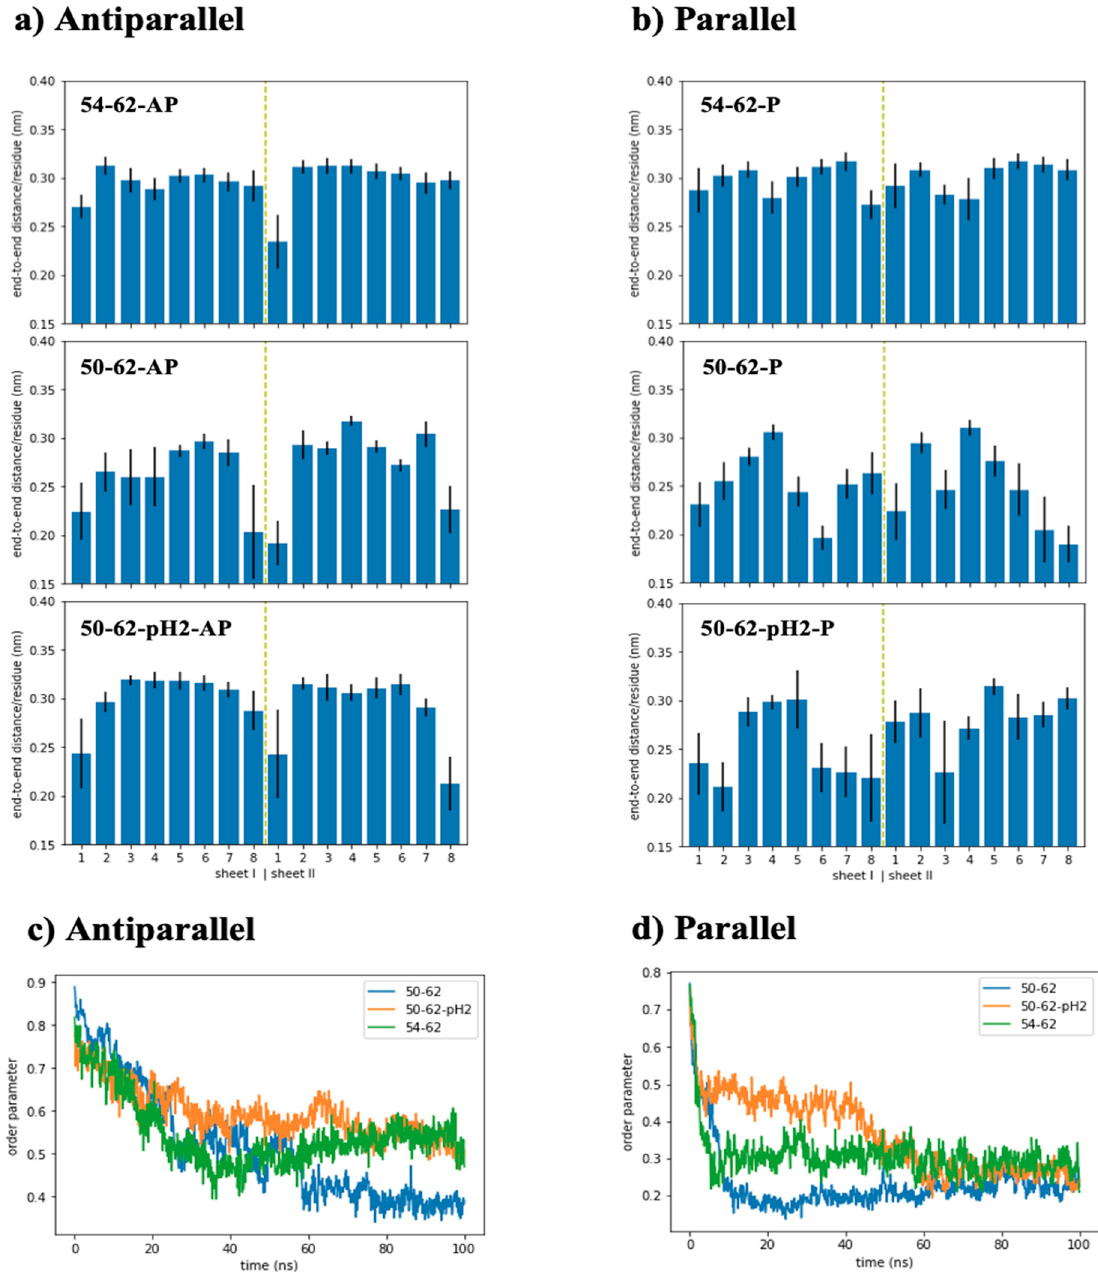
Figure 3. ( a ) time averaged end-to-end distance of each peptide strand from all the antiparallel am- yloid models, ( b ) time averaged end-to-end distance of each peptide strand from all the parallel amyloid models, ( c ) order parameters calculated along 100 ns trajectories of all the antiparallel amyloid models, ( d ) order parameters calculated along 100 ns trajectories of all the parallel amyloid models.